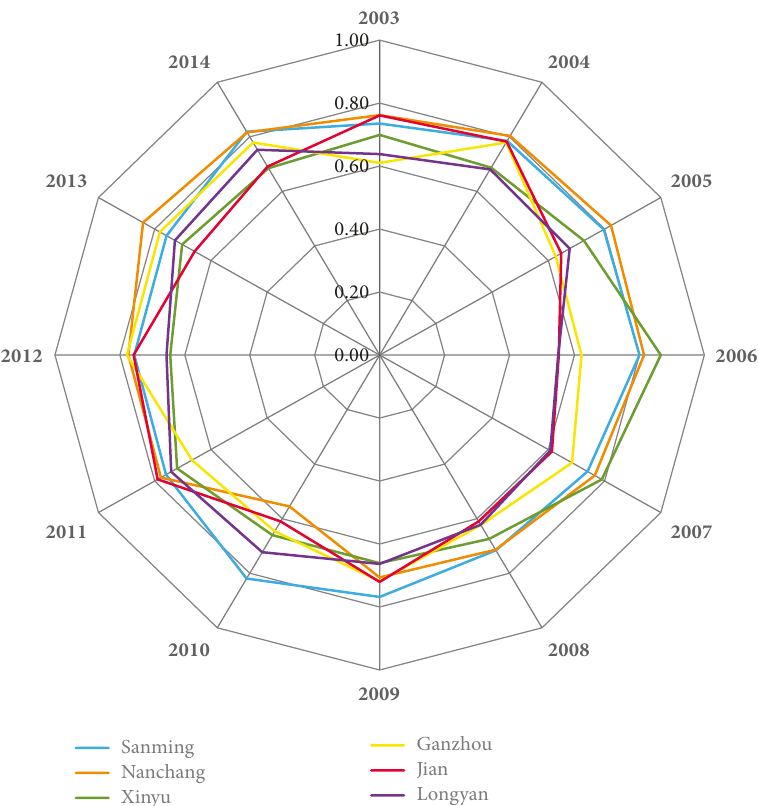
Figure 5: Radar chart of Deng’s correlations between Xiamen Port and its dry ports from 2003 to 2014. Table 6: Results and rankings of Deng’s correlations between Xiamen Port and its dry ports. Sanming Nanchang Xinyu Ganzhou Ji’an Longyan Grey relational grade